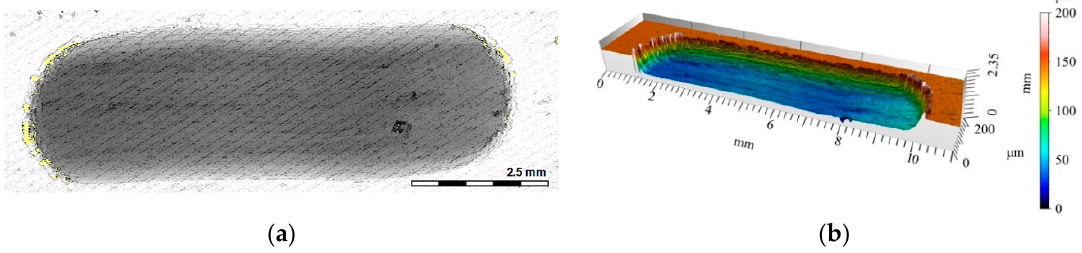
Figure 11. View of wear track in the S10 single composite layer (marked with a gray line in Figure 8a) after dry sliding: ( a ) Digital image; ( b ) Cross-section through 3D view.